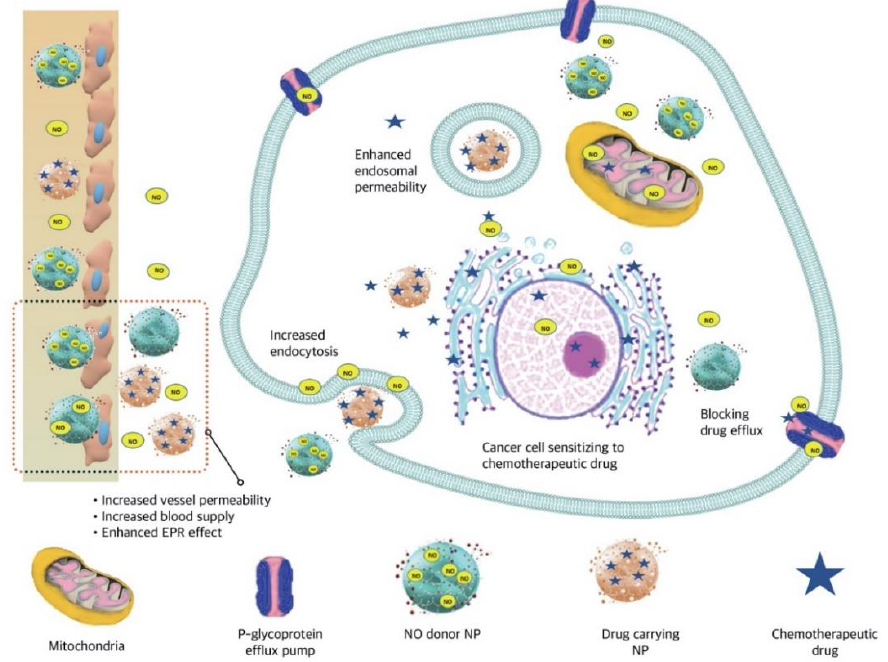
Figure 6. Schematic illustration of combined delivery of intracellular RNS producing and chemotherapeutic delivering NPs. Concurrent use of NO donor particles with NPs delivering chemotherapeutic drug enhanced blood supply and tumor penetration of the NPs. NO released from its donor accelerated endocytosis, enhanced membrane permeability and endosomal escape as well. Intracellular accumulation of both particles followed by the production of ROS and RNS, resulted in depolarization of mitochondrial membrane. Moreover, decrease in drug efflux and resistance through Pgp was another anticancer property of this combination delivery system.